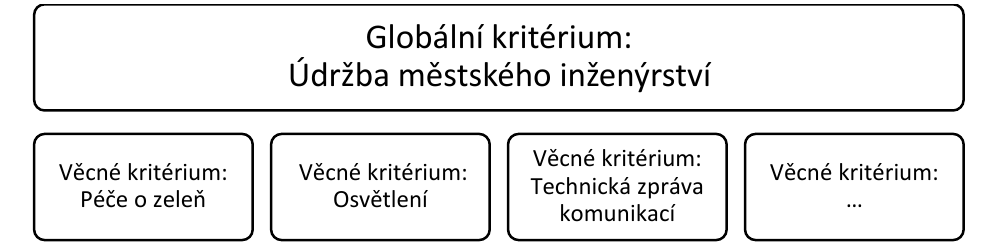
Obr. 6: Obecný postup rozhodovacího procesu, zdroj: